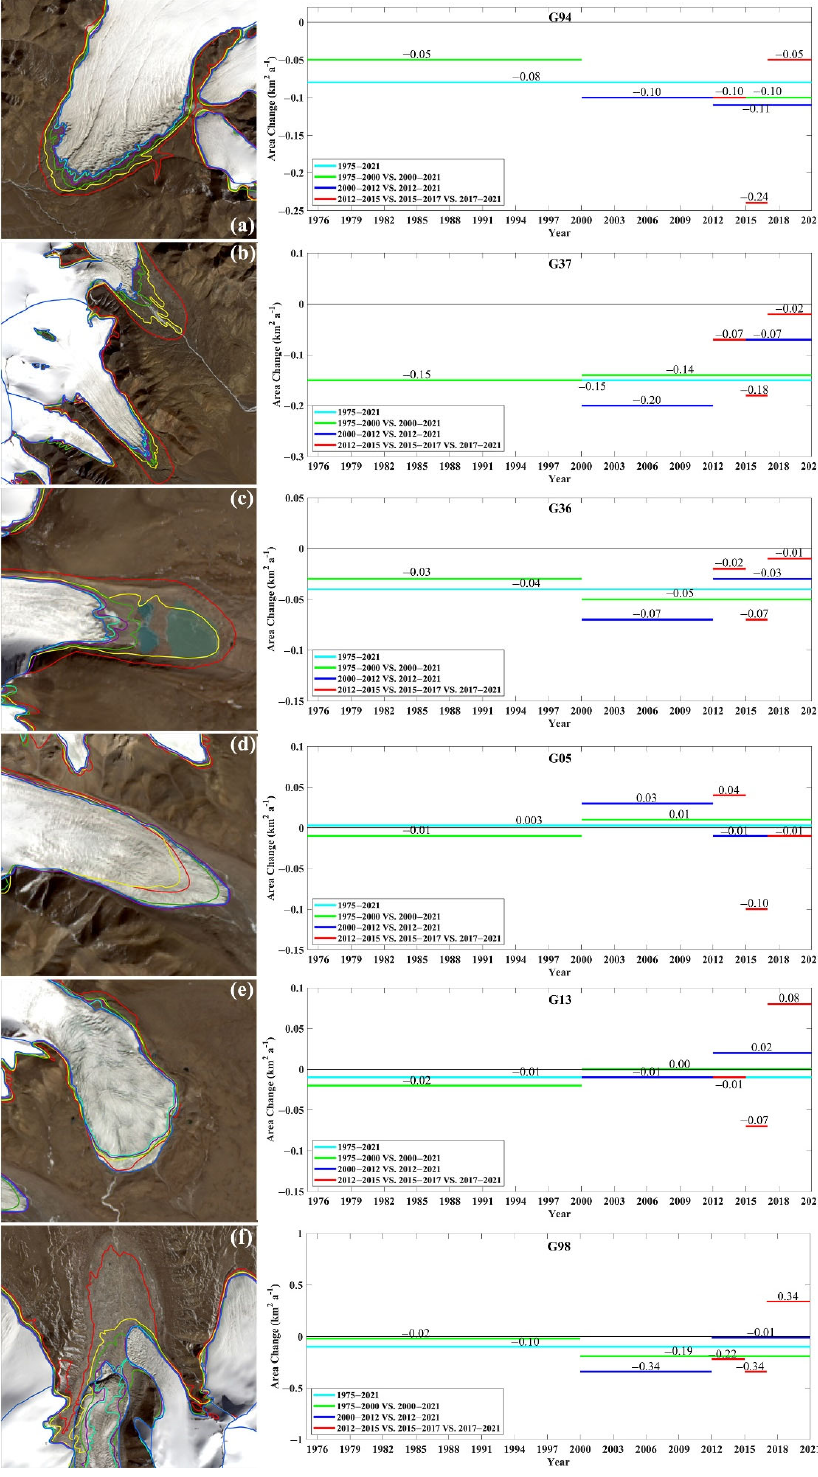
Figure 7. A regional display of the area changes in six typical glaciers: ( a ) the G94 glacier; ( b ) the G37 glacier; ( c ) the G36 glacier; ( d ) the G05 glacier; ( e ) the G13 glacier; ( f ) the G98 glacier.